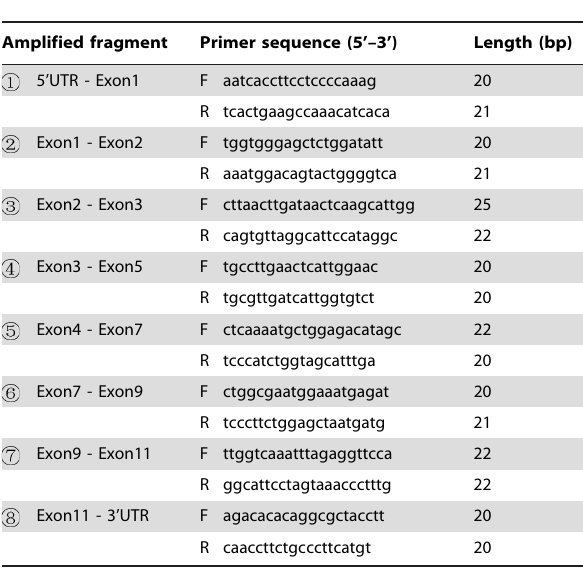
Table 2. Sequences of primers used for CRTISO